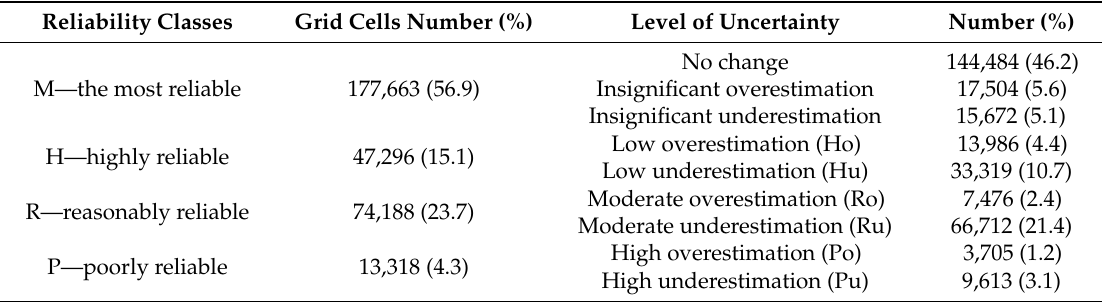
Table 4. Classes of reliability of LandScan data.